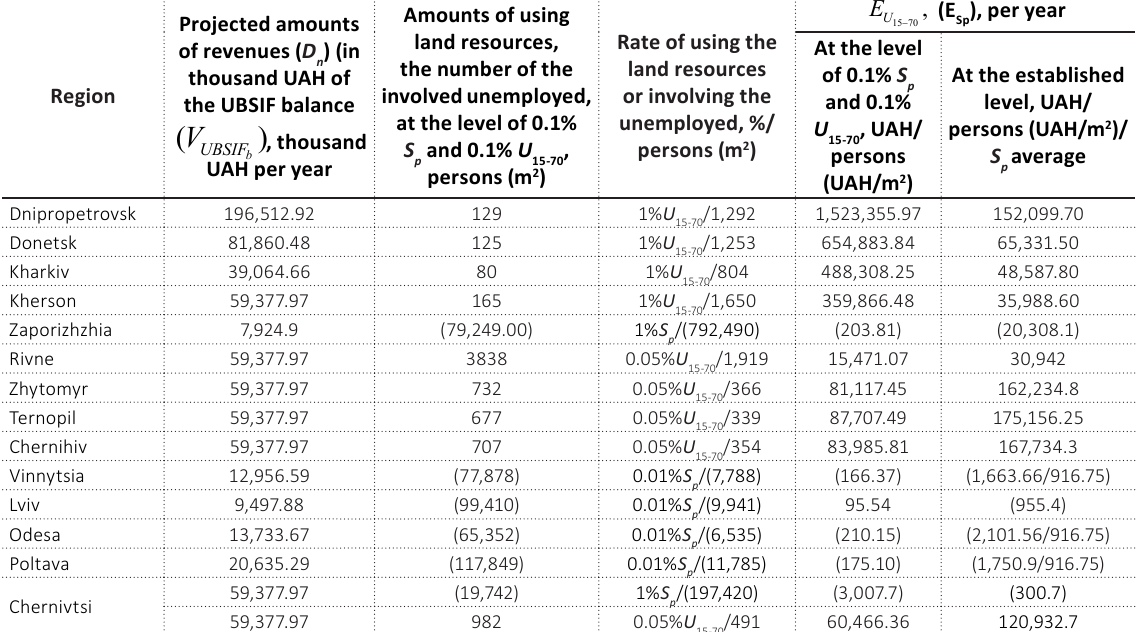
Source : Based on Table 2